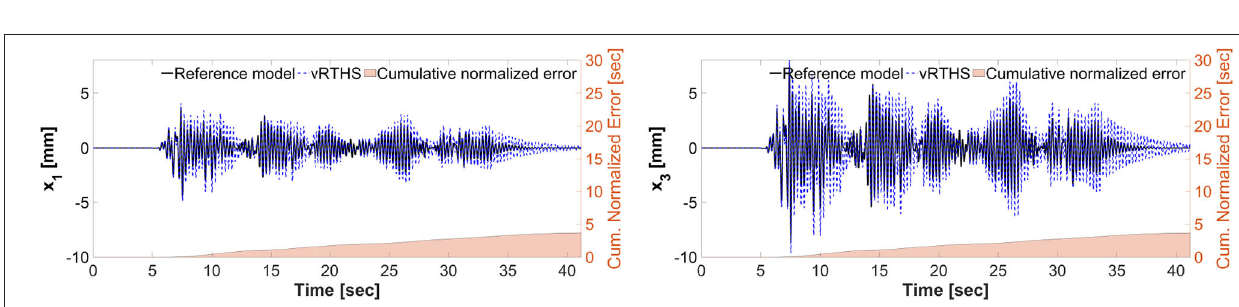
FIGURE 12 | Study 1 (Case 4): vRTHS response comparisons of the 1st and 3rd floor displacements under El Centro excitation.